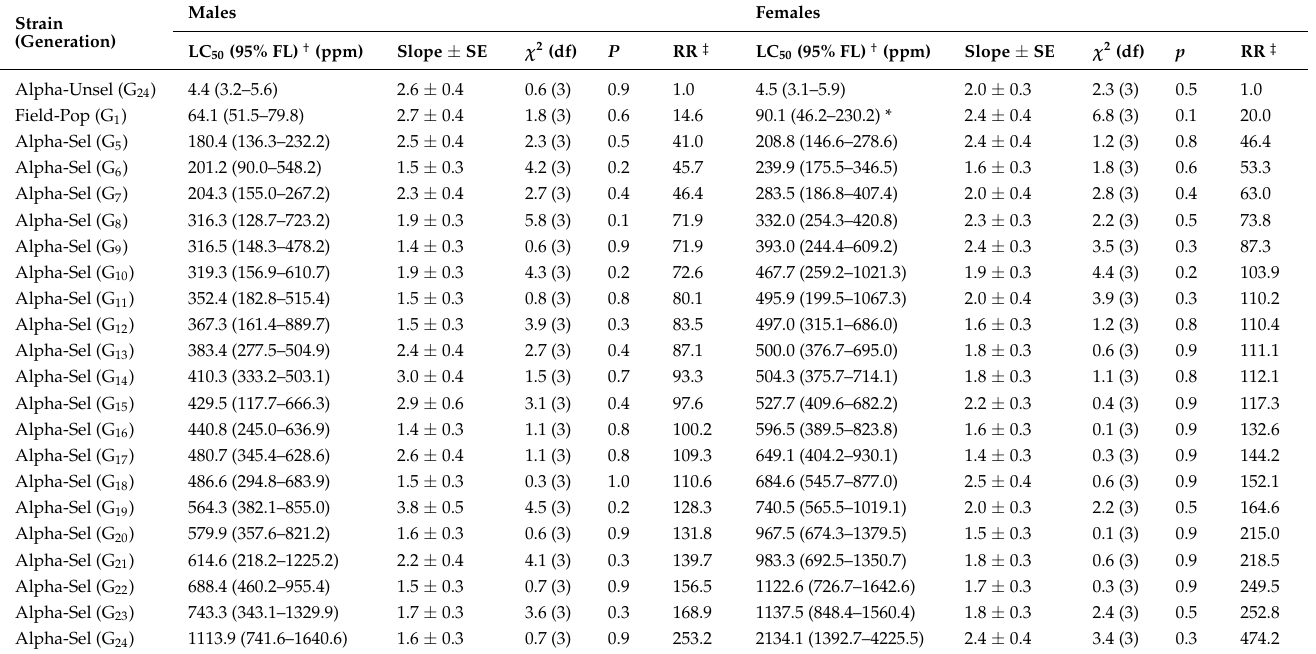
Table 3. Toxicity and development of resistance to alpha-cypermethrin in Musca domestica